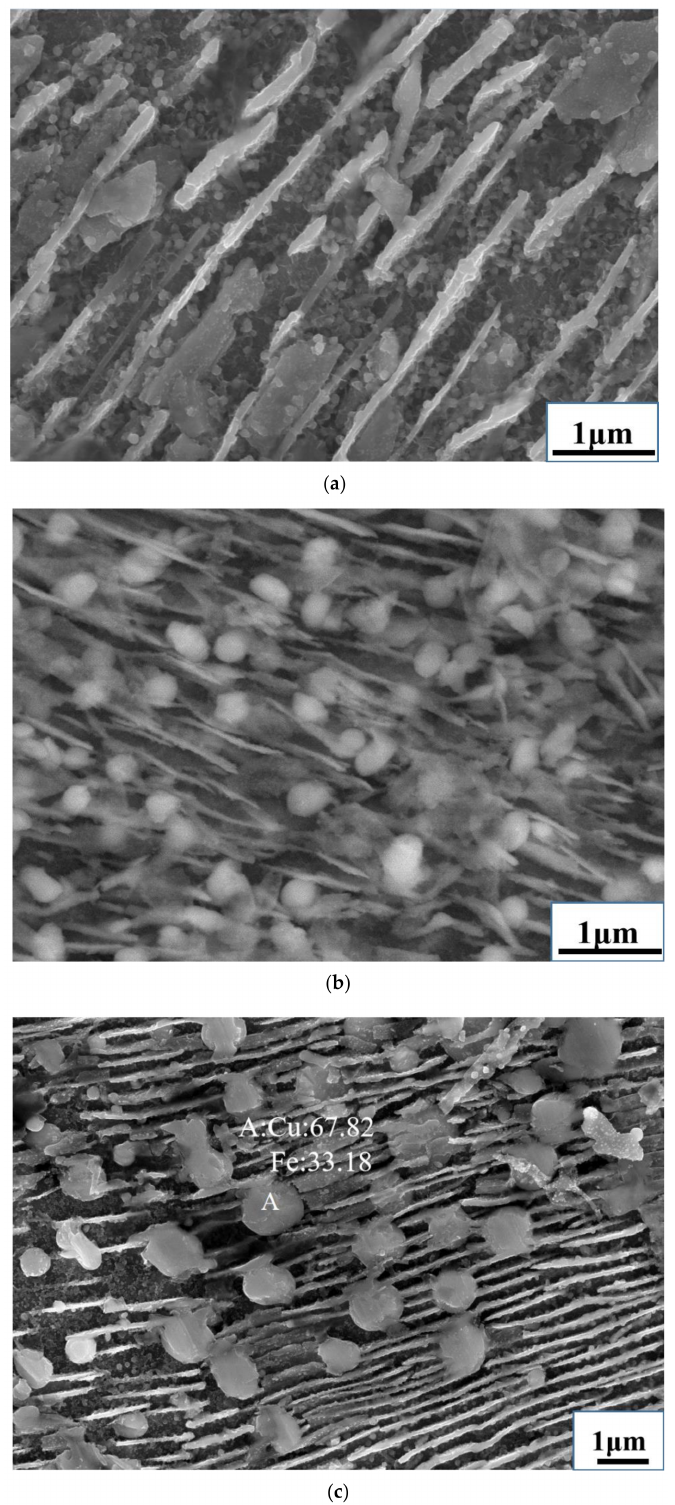
Figure 8. Nano-copper spheres in Cu − Fe ( a ) before desulfurization, ( b ) after desulfurization by Fe–Mn, and ( c ) after desulfurization by CaC 2